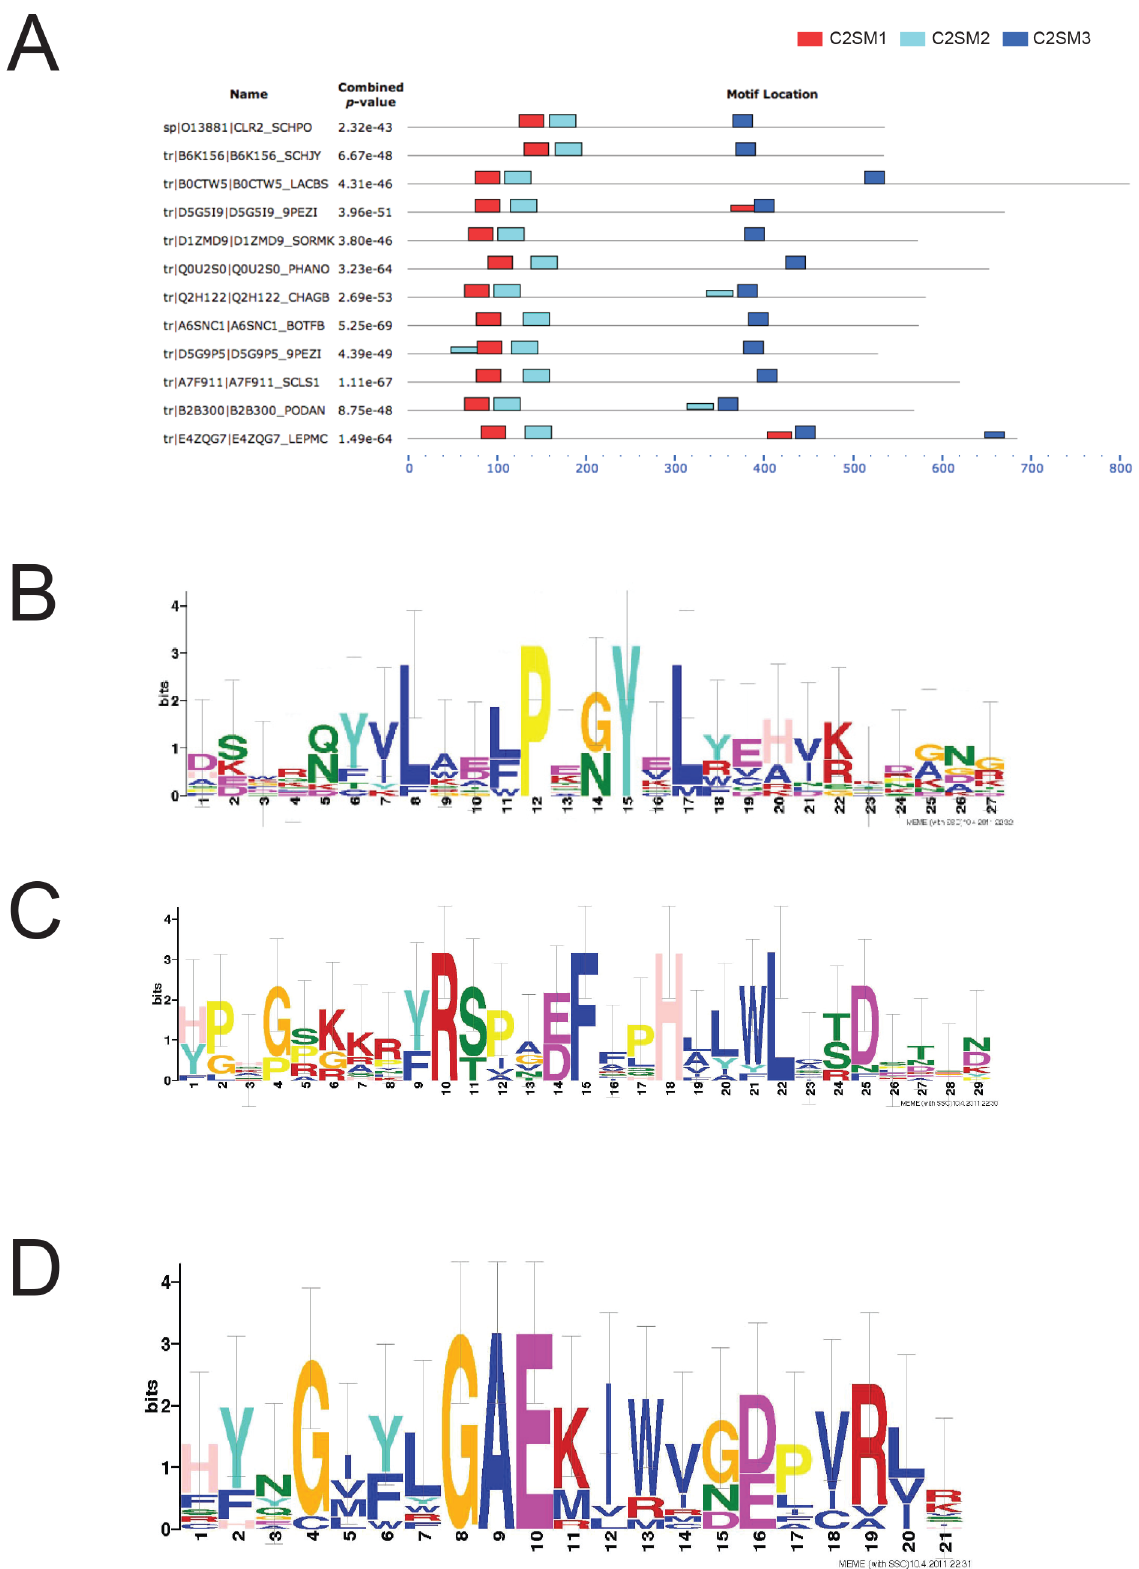
Figure 1. A bioinformatics approach revealed three conserved motifs in Clr2. (A) Sequence alignment between Clr2 and 11 other similar fungal proteins. Three conserved motifs, named C2SM1-3, always present in the same order were identified. C2SM1 (red) and C2SM2 (light blue) are present in the N-terminal part of Clr2 and C2SM3 (dark blue) in the C-terminal part. Height of the boxes reflects significance ( p -value). Logos for the three motifs that highlight conserved residues (B) C2SM1 (C) C2SM2 (D) C2SM3 doi:10.1371/journal.pone.0086948.g001 PLOS ONE | www.plosone.org